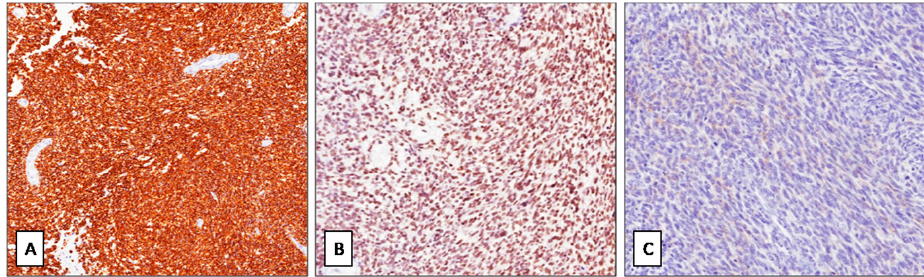
Figure 3. ( A ) Neoplastic cells exhibiting a strong and diffuse staining for desmin (immunoperoxidase; original magnification 100×). ( B ) Diffuse nuclear staining is obtained with WT-1 ( C )-terminus antibody) (immunoperoxidase; original magnification 150×). ( C ) Neoplastic cells are focally and weakly stained with EMA; (immunoperoxidase; original magnification 150×).